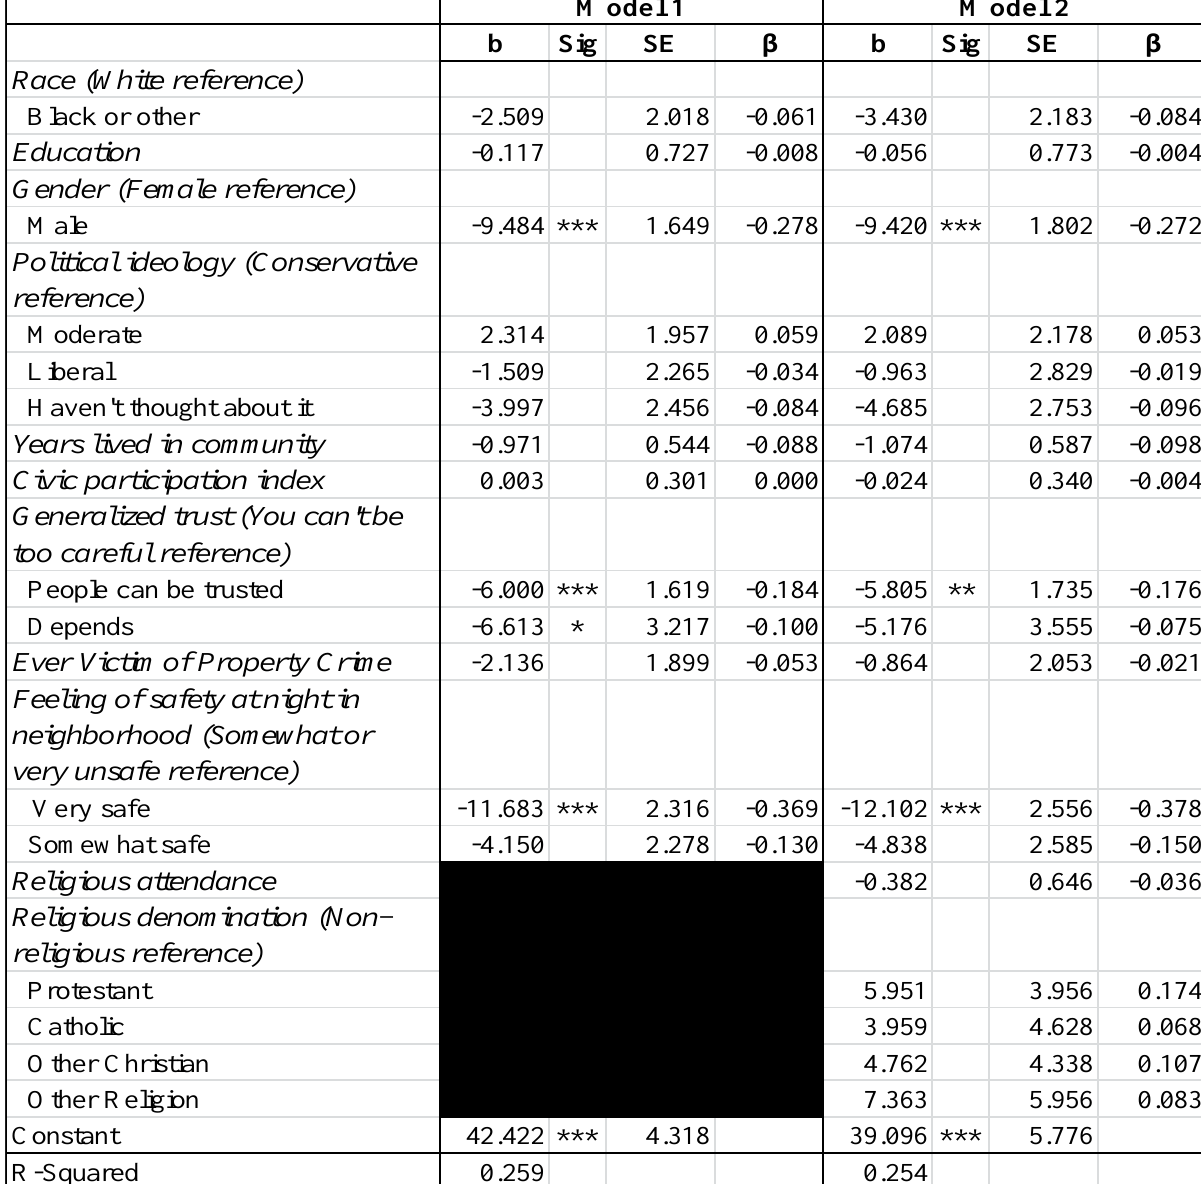
Table 3. OLS Regression of Predictors of Fear of Violent